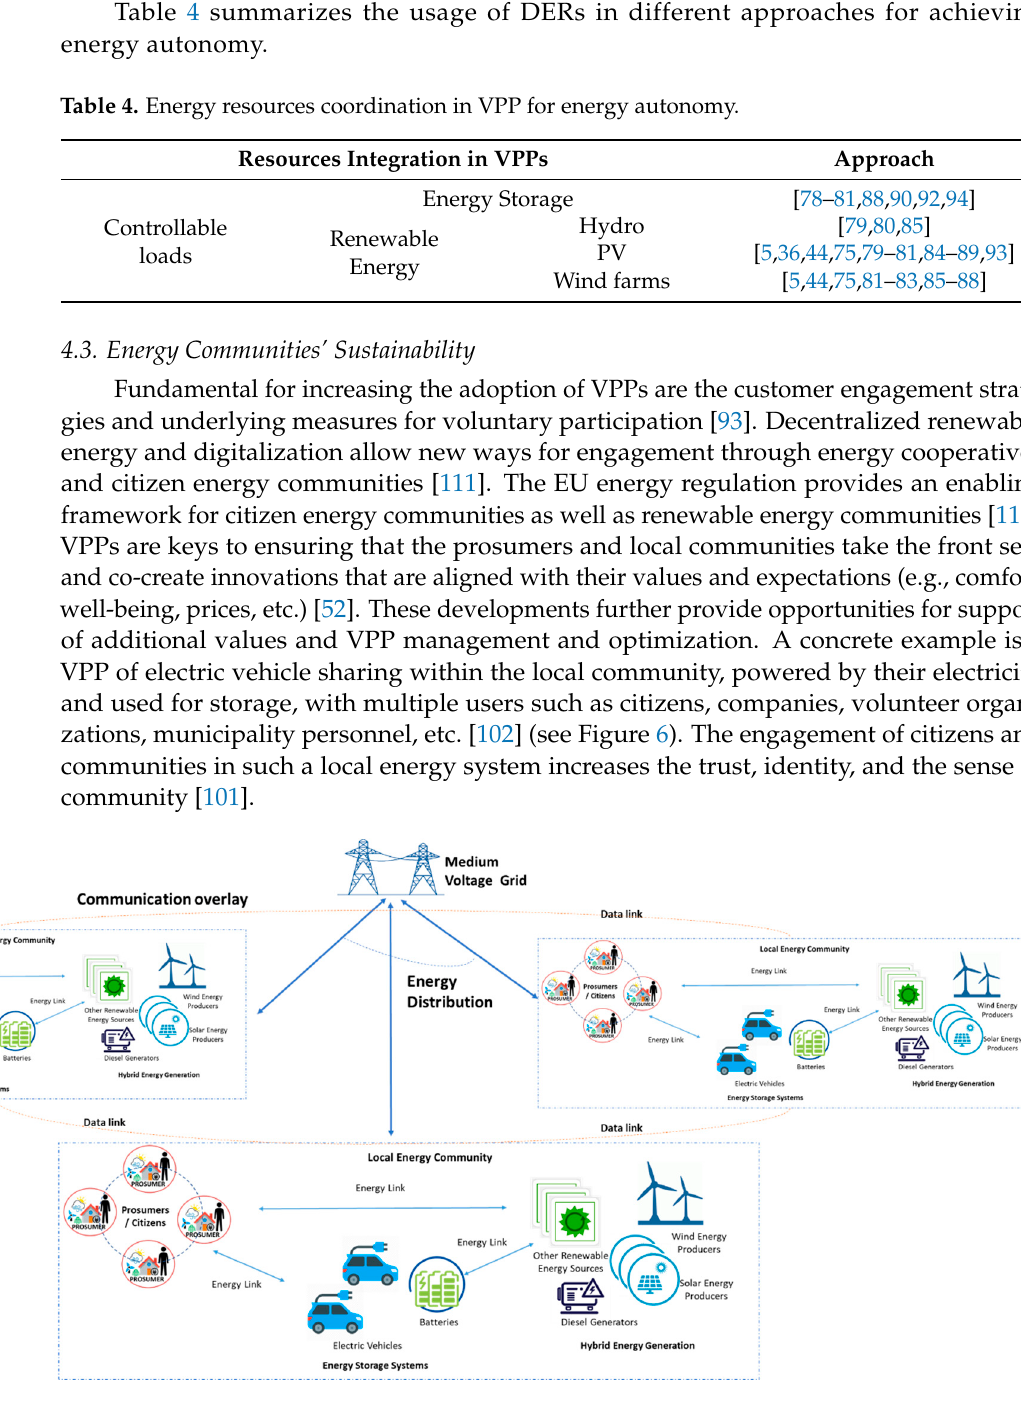
Figure 6. VPP for energy communities.